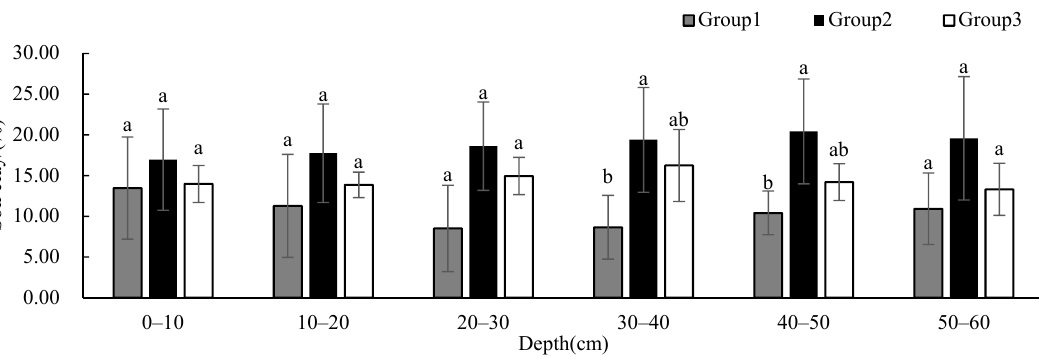
Figure 7. One-way ANOVA results of soil clay contents under different vegetation cover types at different depths ( p < 0.05; a > b).